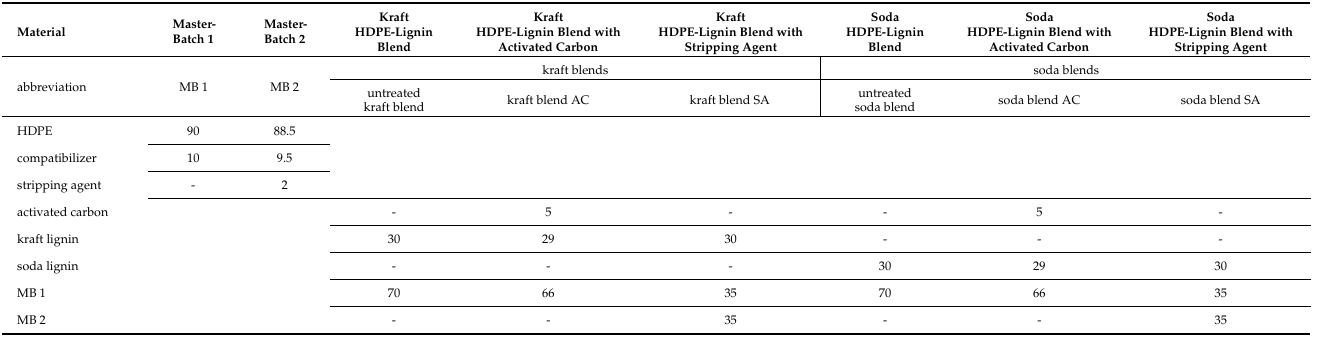
Table A1. Formulation of masterbatches and HDPE-lignin